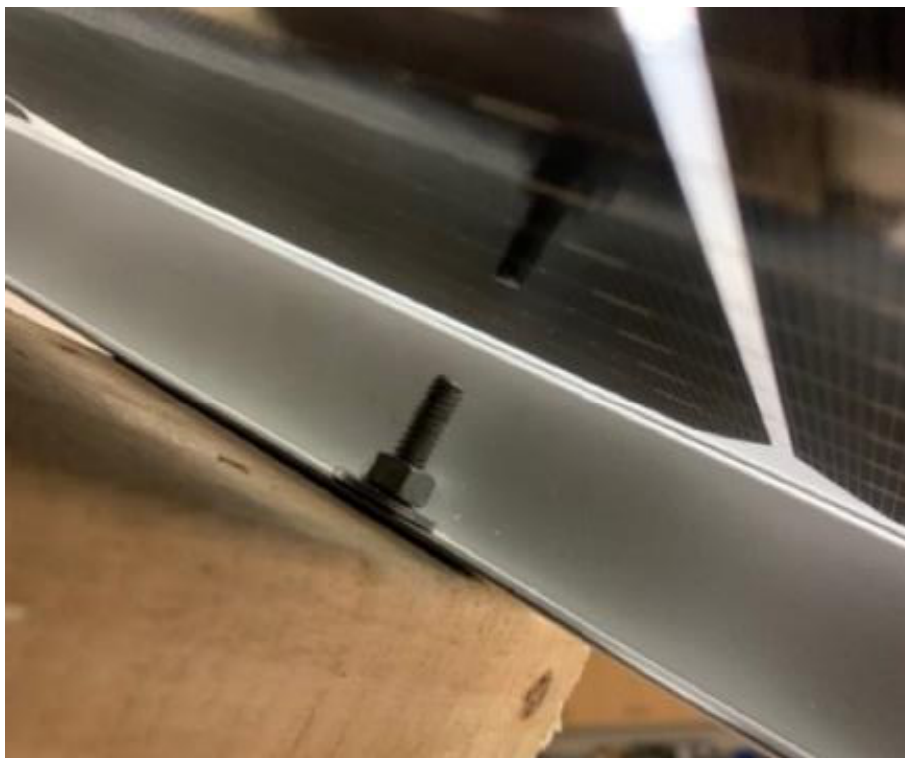
Figure 5. ¼″ × 2 - 1/2″ carriage bolt, nut, and washer used to secure the connection.